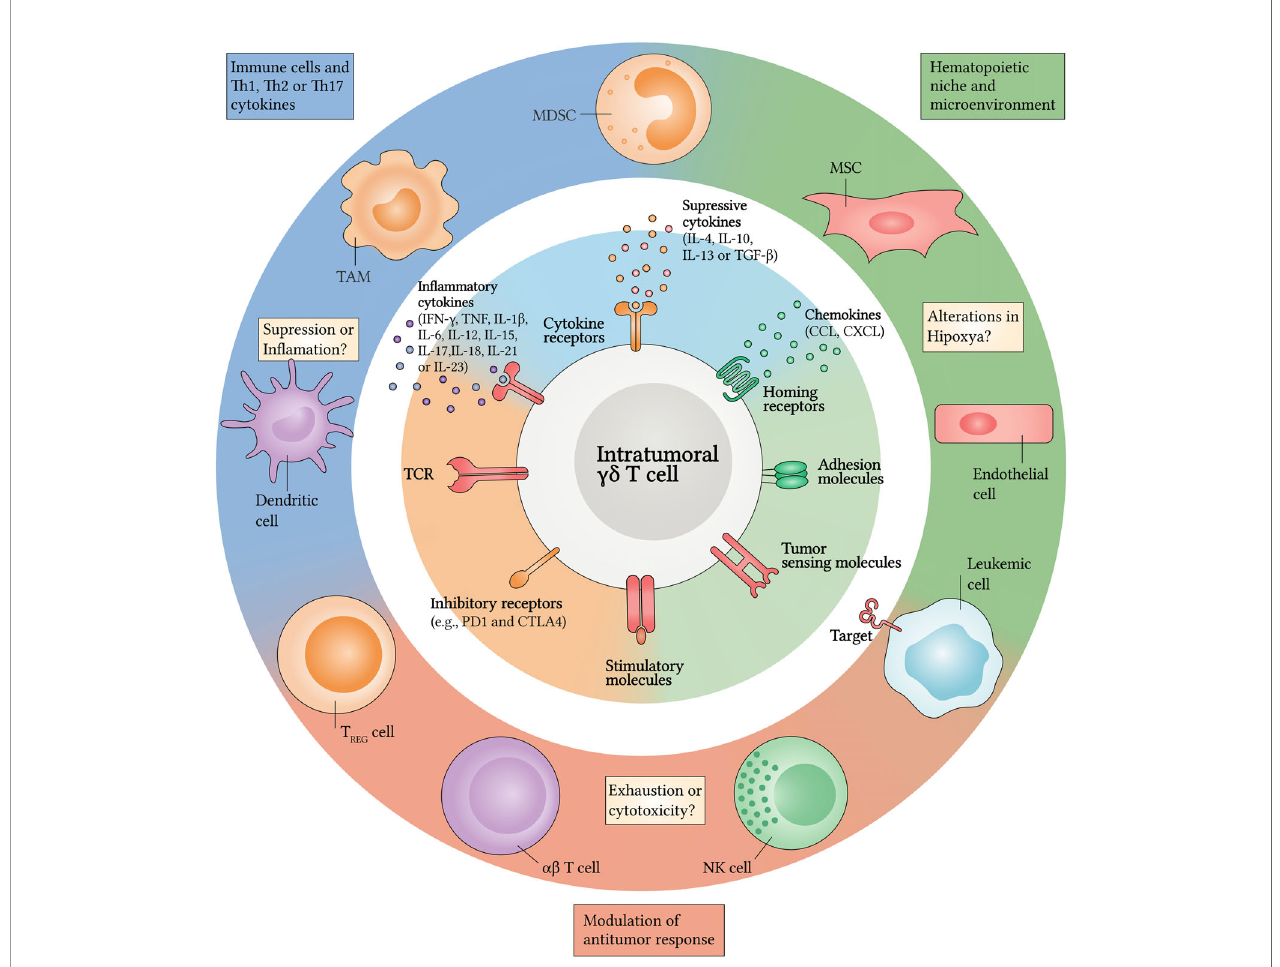
FIGURE 1 | Crosstalk between gd T cells and the leukemic microenvironment. Upon in fi ltrating the TME, gd T cells are exposed to several persistent in fl ammatory and/or suppressive signals. Pathways implicated in crosstalk with the leukemic microenvironment can be classi fi ed into three general categories (center and inner circle): (i) cell-to-cell signals including antigen recognition by gd T cell receptor (TCR), stimulatory or inhibitory molecules and/or tumor-sensing molecules; (ii) soluble factors such as cytokines and chemokines that will drive changes in expression levels of (iii) homing receptors and adhesion molecules. Several stromal and/or immune cells could be the source of many of these changes (outer circle). Among these, tumor-associated macrophages (TAM), myeloid-derived suppressor cells (MDSC), regulatory T (Treg) cells and dendritic cells (DC) retain their reprogramming potential into the TME by regulating in fl ammation or suppression through Th1, Th2 and Th17 cytokines. In addition, the hematopoietic niche can regulate hypoxia, responsible for supporting leukemic cells (LC) survival. Mesenchymal stromal cells (MSC) and endothelial cells can also express many factors that attract antitumor cells, such as gd T cells, ab T cells and NK cells which can exert cytotoxicity or undergo cell exhaustion after in fi ltrating the leukemic microenvironment. CCL, CC-chemokine ligand; CTLA4, cytotoxic T lymphocyte antigen 4; CXCL, CXC- chemokine ligand; PD1, programmed cell death protein